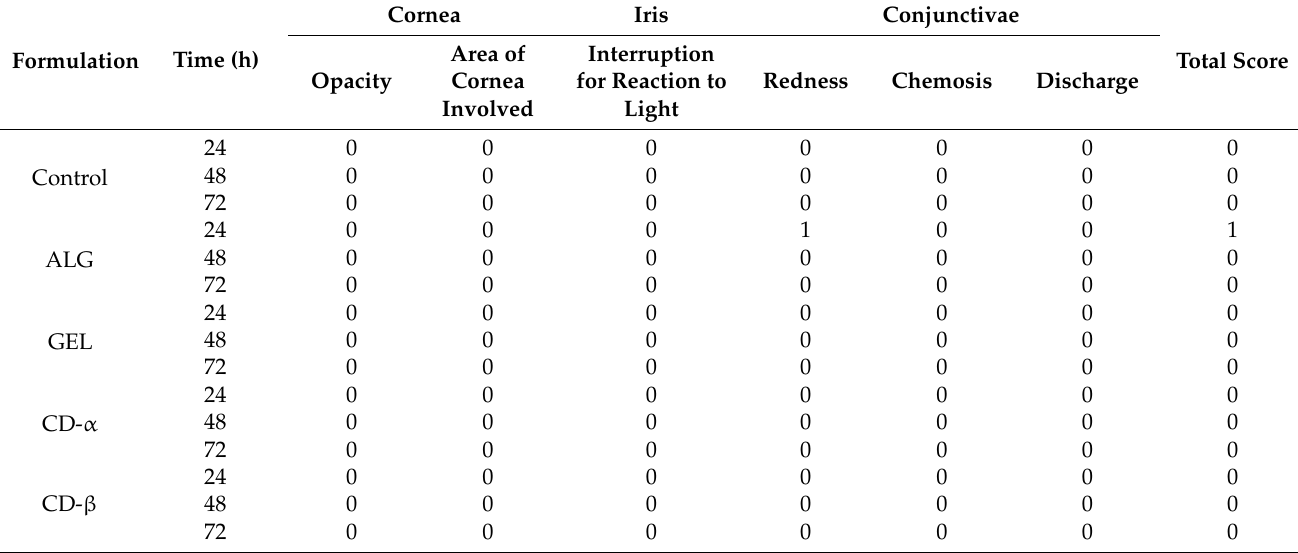
Table 5. Ocular irritation test according to Draize